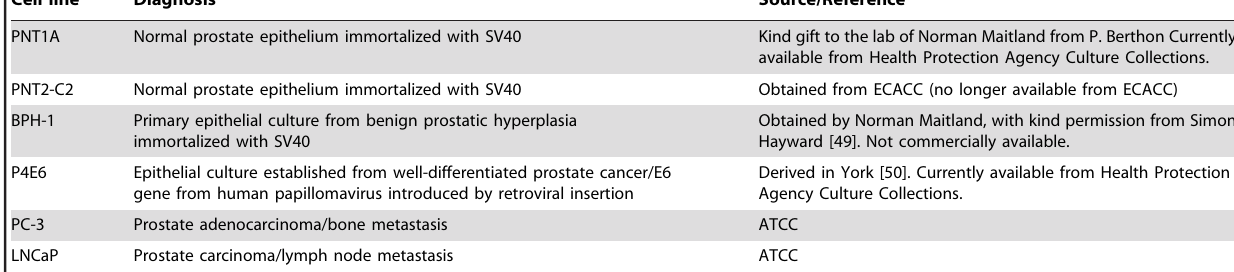
Table 1. Cell lines.